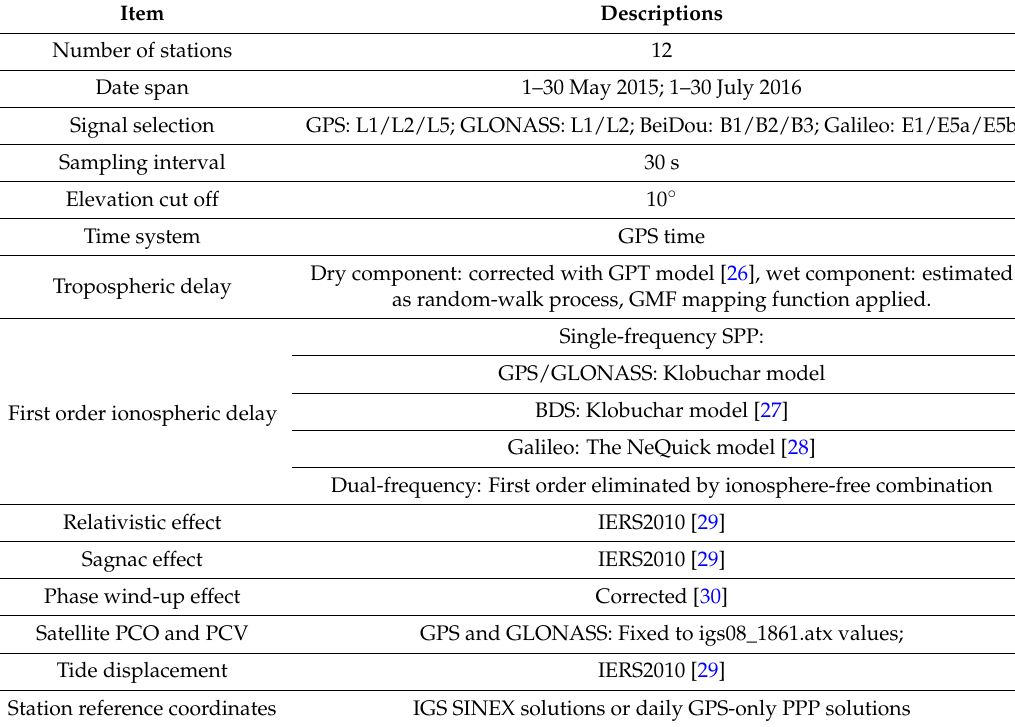
Table 1. Summary of observation model and data processing strategies for SPP and